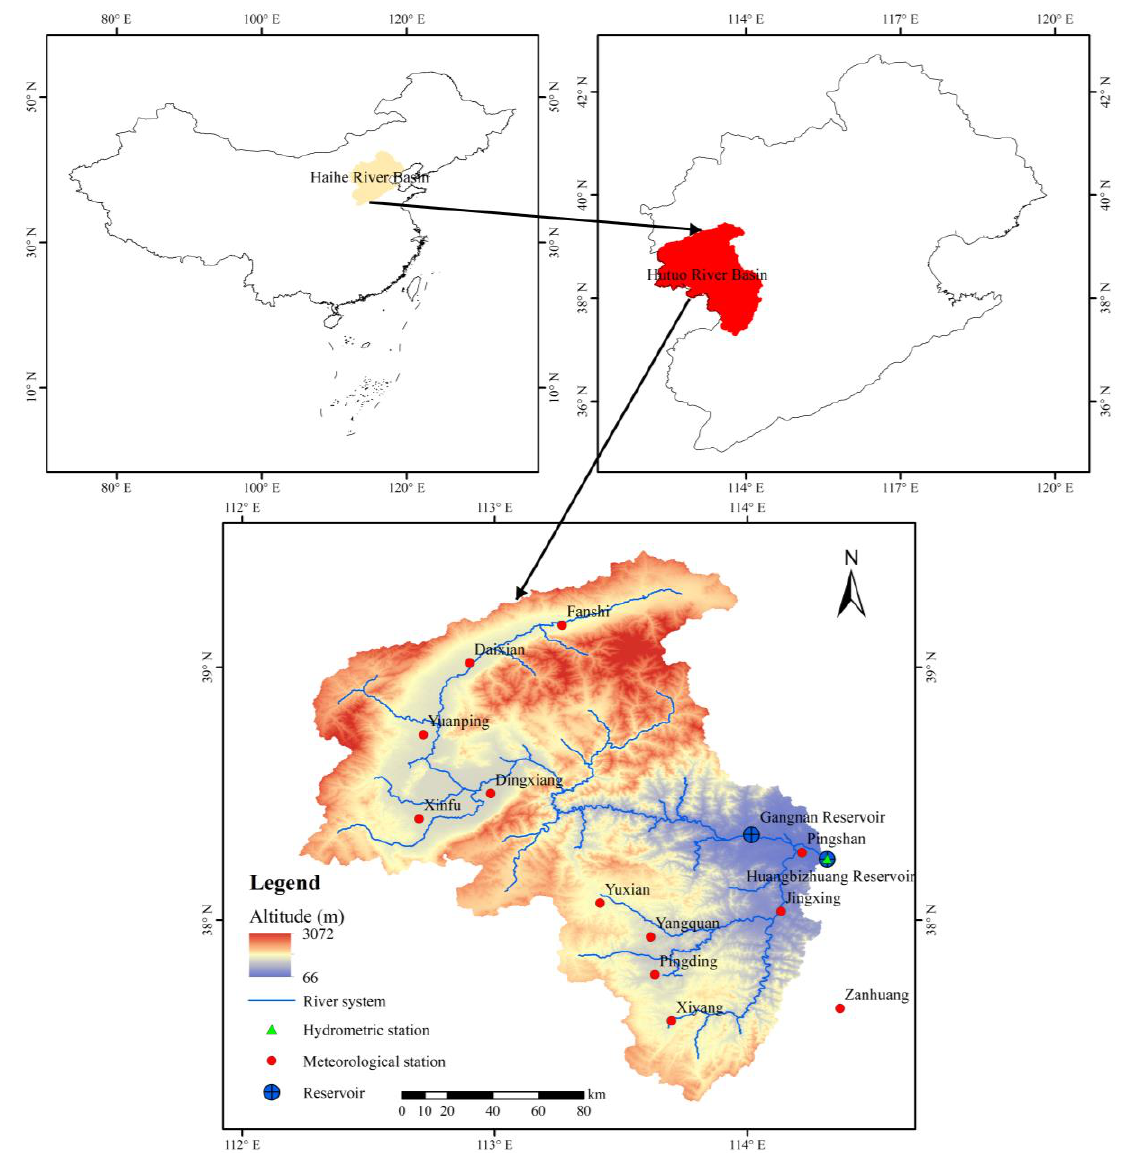
Figure 1. Geographical map of the upper Hutuo River Basin.